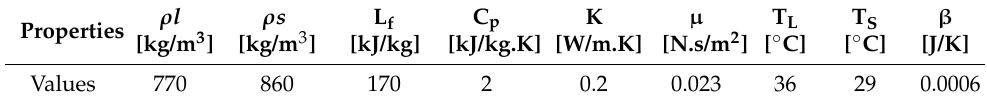
Table 1. Thermo-physical properties of Paraffin R-T35